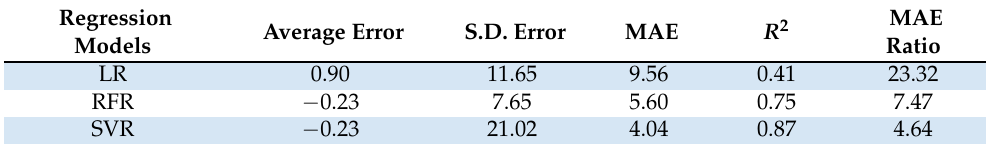
Table 4. Performance of Tilapia Depth Estimation with LR, RFR, and SVR methods.